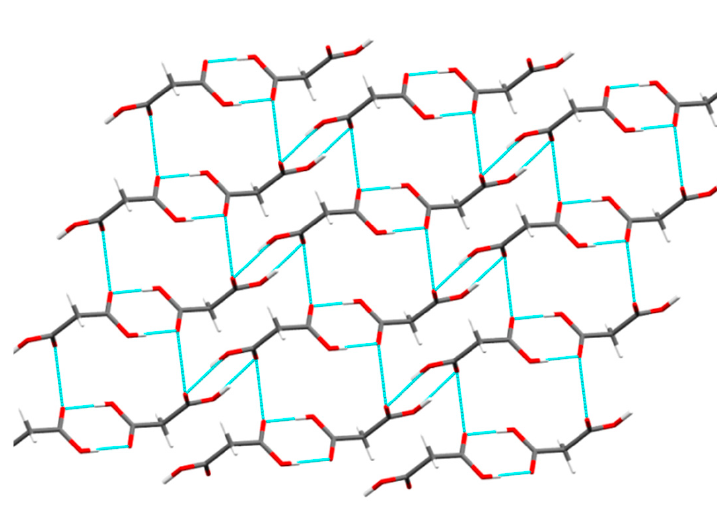
Figure 10. Crystal structure of MAL illustrating 3D hydrogen bonding network with strong intermolecular interactions.